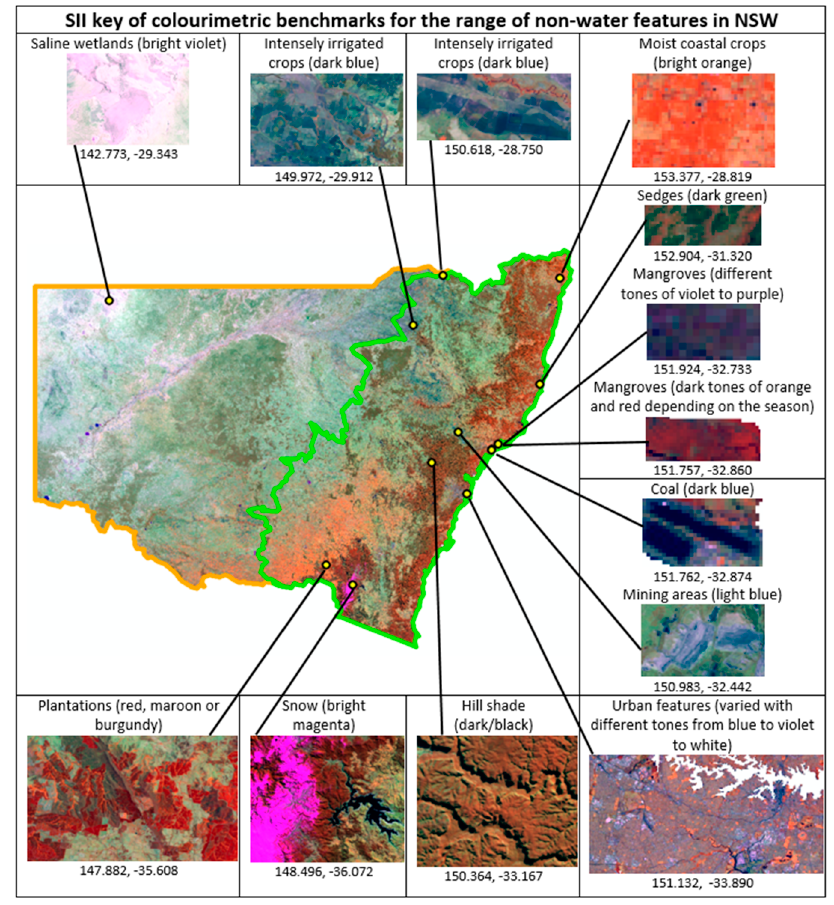
Figure 4. SII key colourimetric benchmarks for the variety of non-water features in NSW. Images viewed with a stretch of 2.5 standard deviations and a gamma of 1.5 in the ‘Land/Water’ RGB composite at 100 m resolution. All location co-ordinates are in decimal degrees.